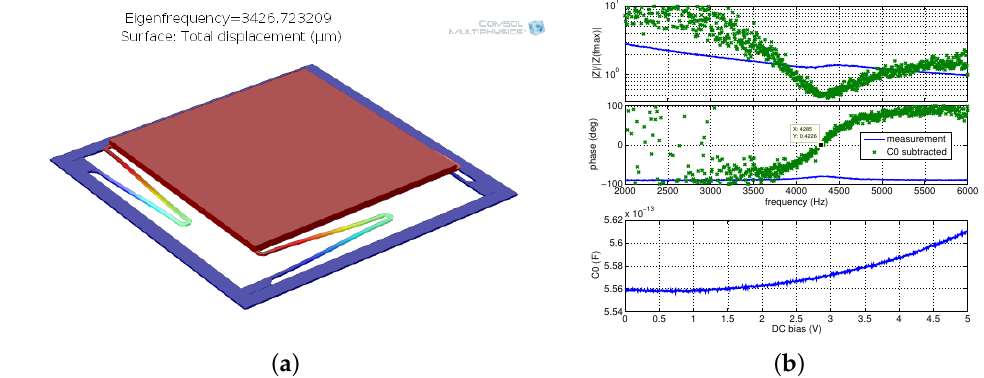
Figure 14. Device 04: modal simulation indicating eigenfrequency at 3.43 kHz ( a ); and impedance measurements with resonance at 4.29 kHz ( b ).